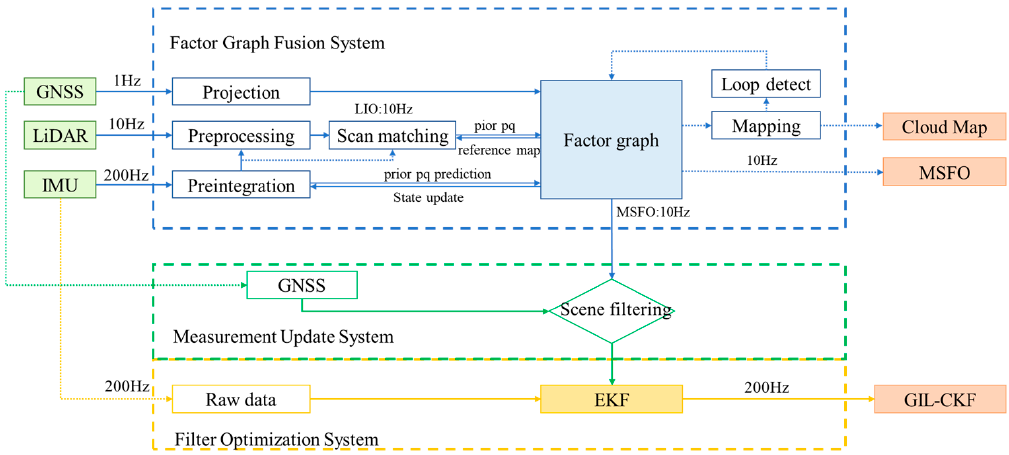
Figure 3. GIL-CKF System Overview. The whole system is divided into three parts: (1) a factor graph fusion system, (2) a measurement update system, and (3) a filtering optimization system. The first part provides low-frequency high-precision fusion information, which is filtered together with GNSS by the second-part scene filtering to provide high-precision measurement for the filter in the third part.